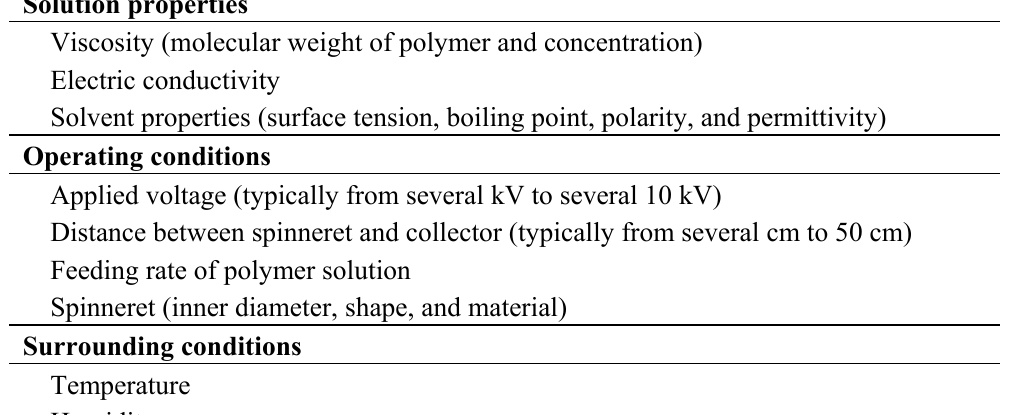
Table 1. Control parameters for morphology and diameter of electrospun fibers (Adapted from